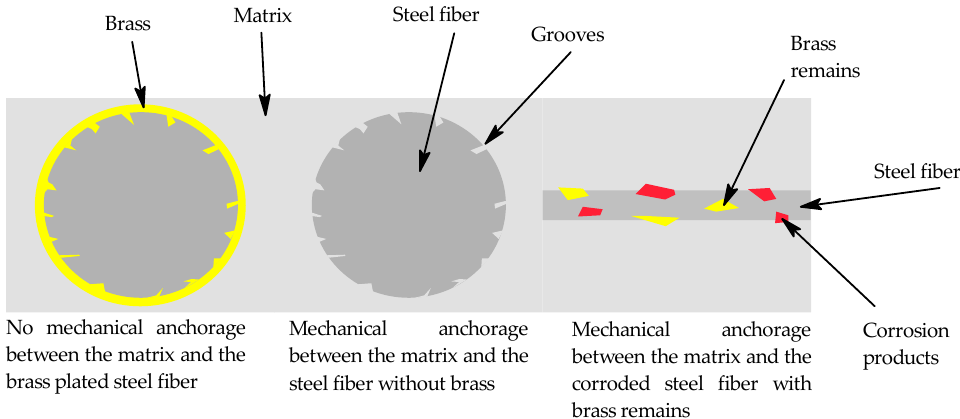
Figure 9. Scheme of possible mechanisms encountered regarding the steel fiber-matrix